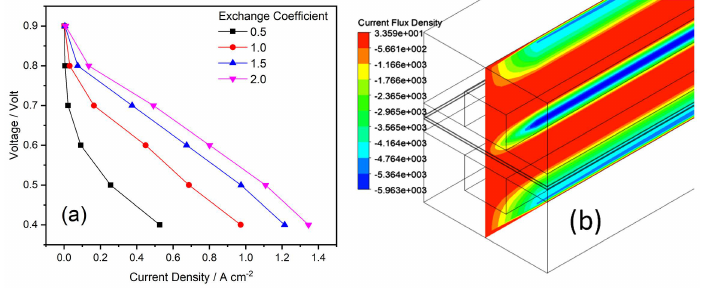
Figure 6. ( a , b ) Effects of exchange coefficient on PEMFC performance: ( a ) Polarization curves of exchange coefficient; and ( b ) Contours of the current flux density at 0.6 V for exchange coefficient value of